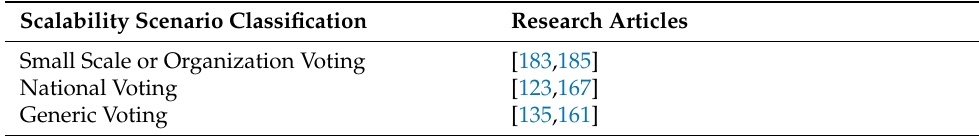
Table 13. Scalability scenario classification.